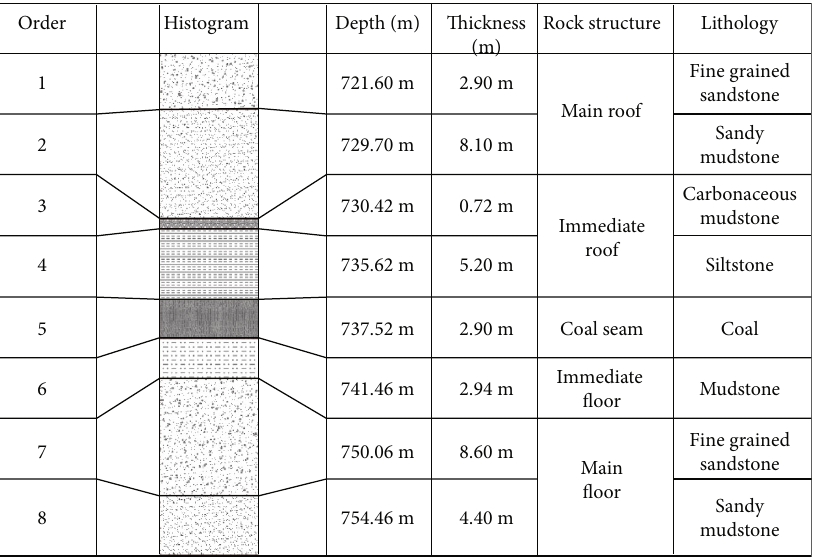
Figure 2: Geological histogram.